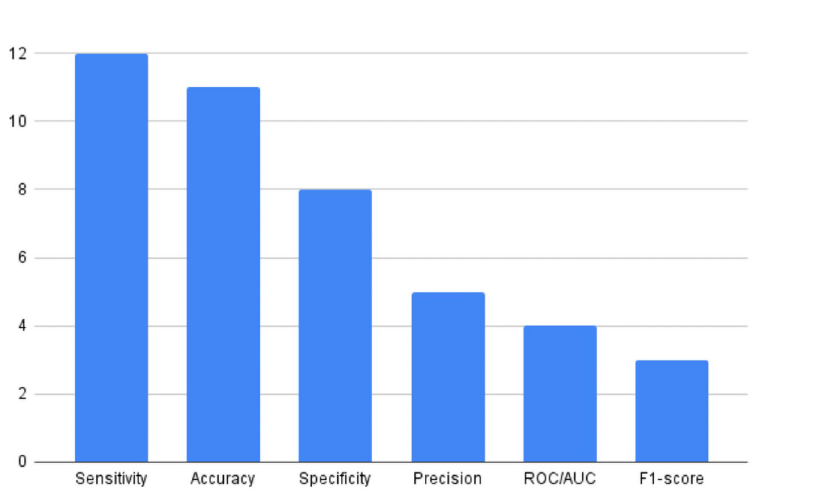
Fig 4. Metrics used to evaluate the models proposed in the